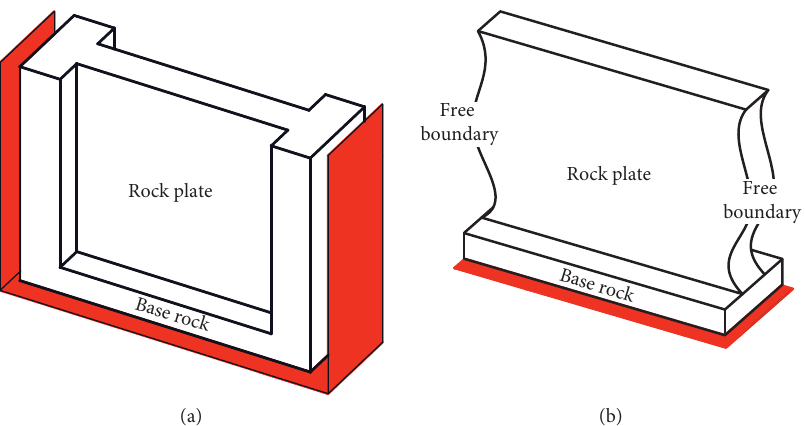
Figure 3: Rock plate with different constraint boundaries: (a) three sides fixed and one side free and (b) one side fixed and three side free.